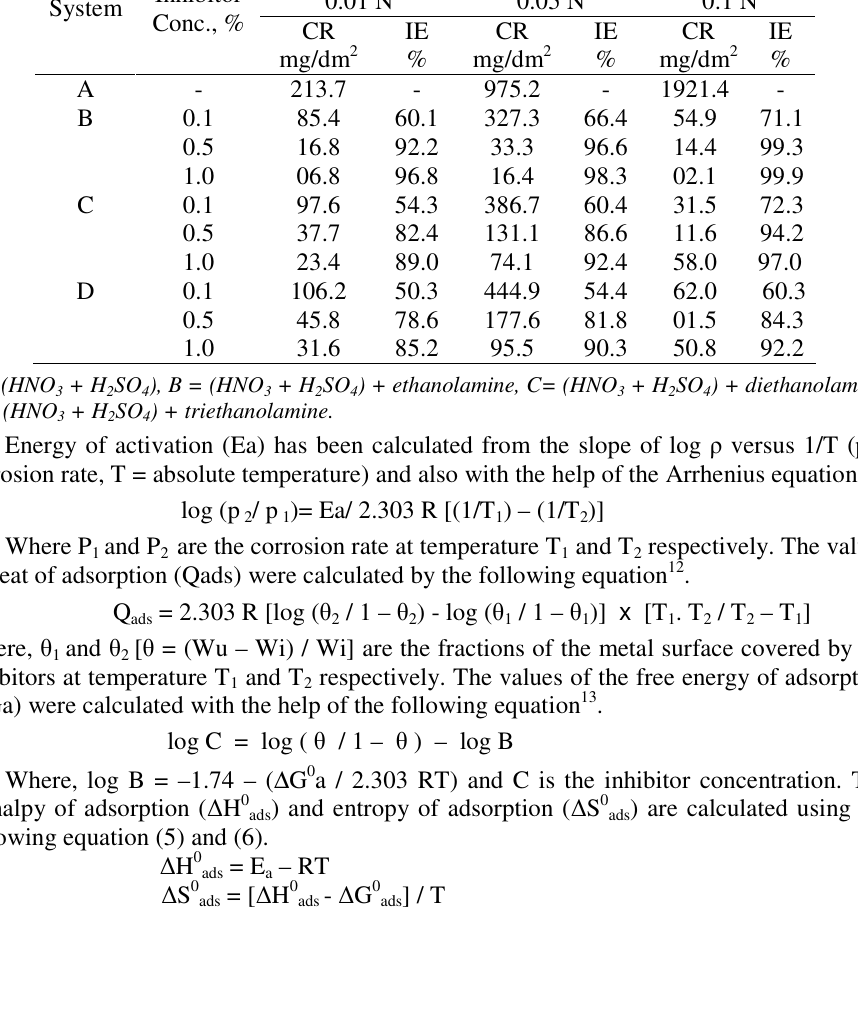
+ 0.01 3 + 0.1 N H SO ) mix acid 3 2 4